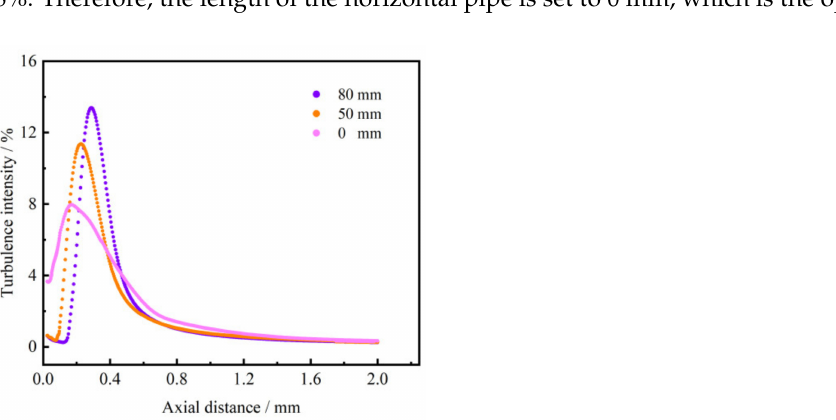
Figure 12. Disturbance of flow field according to length of horizontal section of L-shaped injection